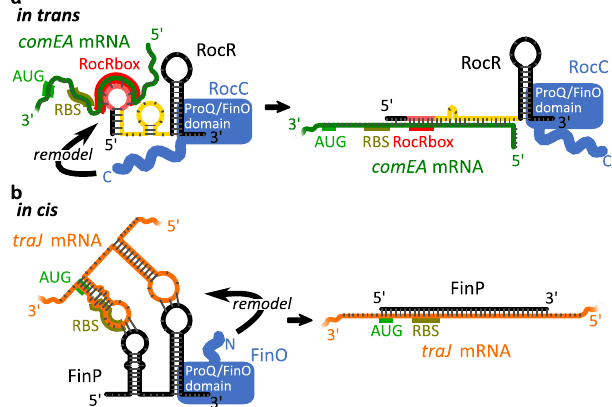
Fig. 6 | ProQ/FinO domain proteins bind transcriptionalterminatorstructures to regulate RNA-RNA interactions. a Many ProQ/FinO domain proteins, such as RocC, facilitate in trans RNA association between sRNAs and target mRNAs. The ProQ/FinO domain speci fi cally binds the transcriptional terminator of the RocR sRNA, stabilizing it against degradation. Key to RNA-RNA association is the recog- nitionofthesRNAseed sequencewithitscomplementaryregion(theRocRbox)in the target mRNA. The C-terminal region of RocC is required to facilitate the recognition and translational repression of target mRNAs such as comEA. b Many plasmid-encoded ProQ/FinO domain proteins, such as FinO, regulate in cis sense- antisense RNA interactions. Similar to RocC, the ProQ/FinO domain of FinO also stabilizestheantisense RNAFinP againstdegradation.InitialRNA-RNAinteractions are thought to involve loop – loop kissing interactions, which then proceed to duplexformationbetweenthetwoRNAs,resultingintranslationalrepressionofthe traJmRNAtarget.Inthiscase,the fl exibleN-terminalregionofFinOisthoughttobe key in facilitating RNA-RNA